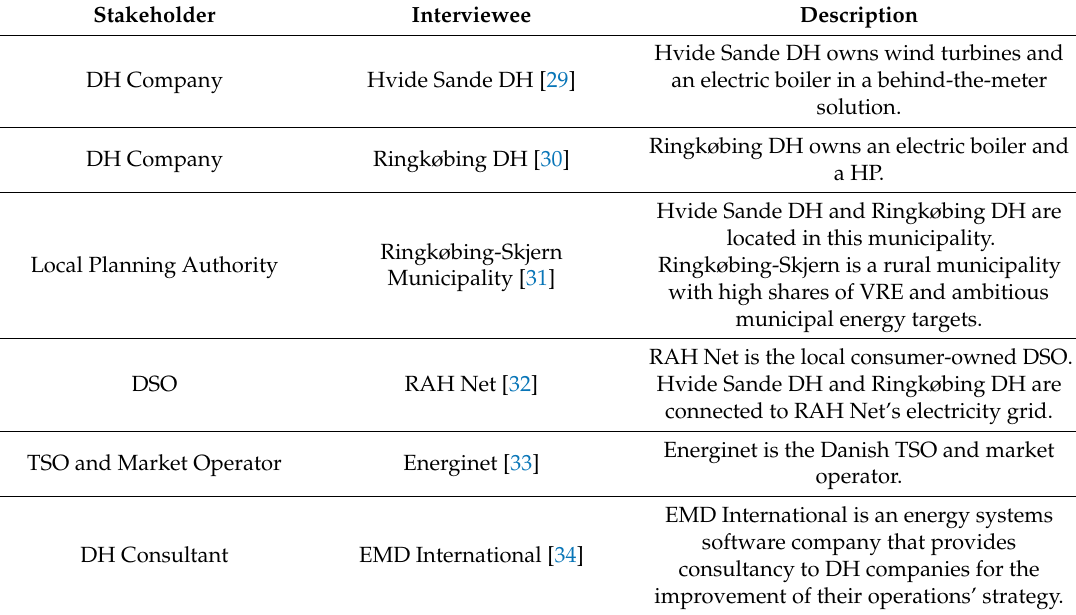
Table 1. List of interviewed stakeholders. HP: heat pump; TSO: transmission system operator; DSO: distribution system